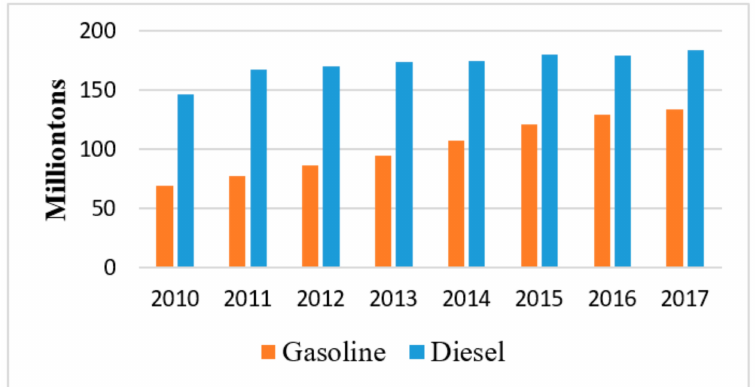
Figure 1. The statistic gasoline and diesel consumption from 2010 to 2017 [1].